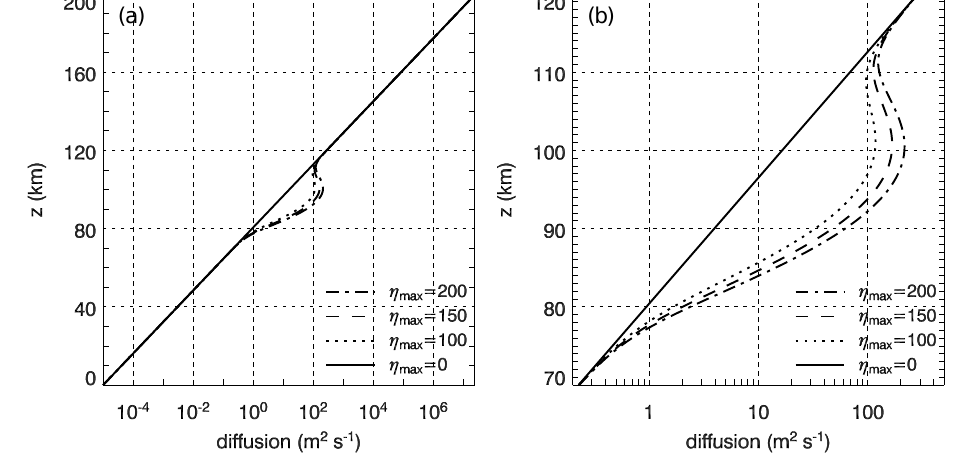
Fig. 1. (a) Profiles of total diffusion in the height range of 0–200km. The solid, dot, dash, dash-dot lines are for η max = 0, 100, 150, 200m 2 s − 1 . (b) Enlarged portion of (a) .